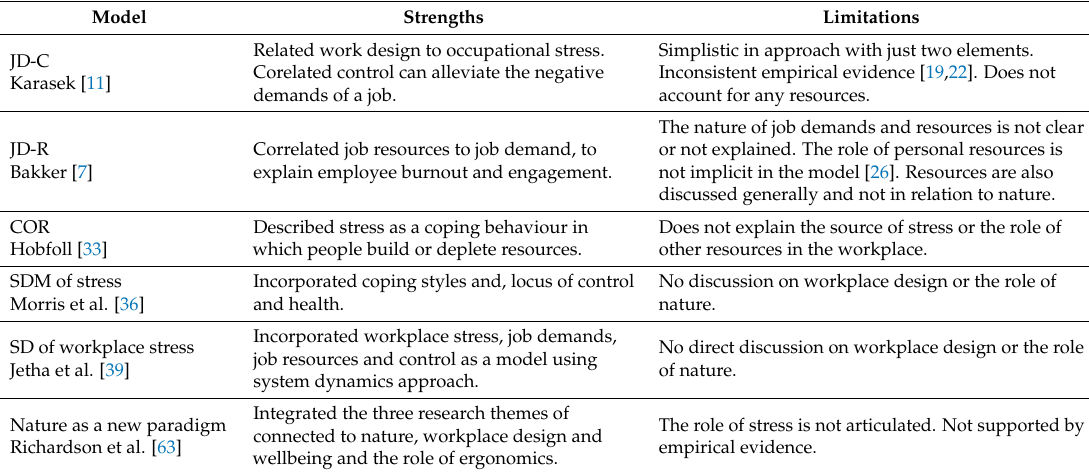
Table 4. Summaries of models and concepts.